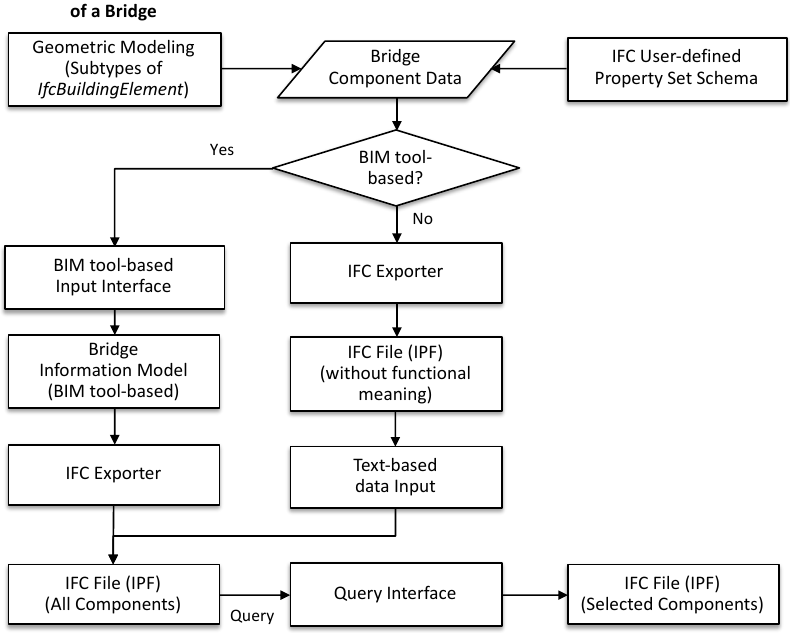
Figure 7. Basic framework for IFC-based bridge information modeling process.